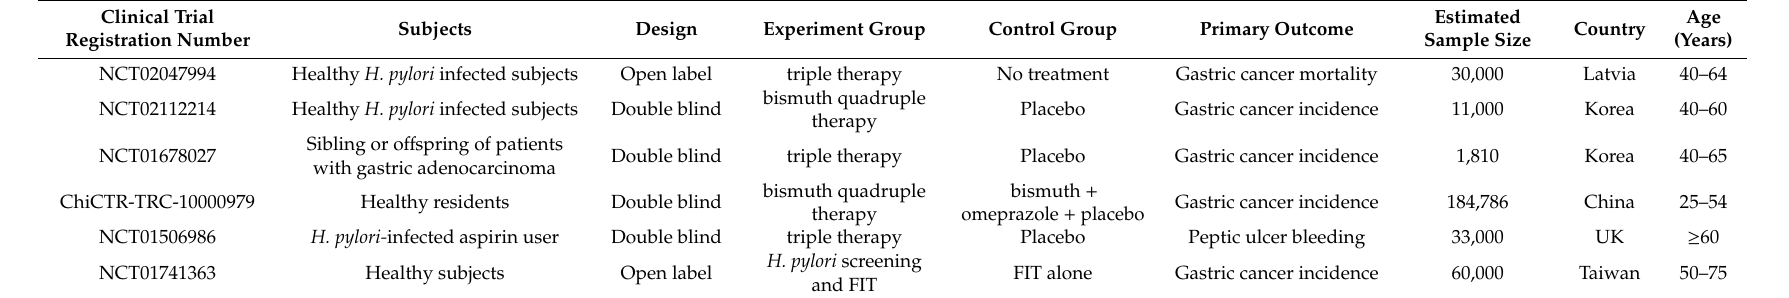
Table 3. Ongoing trials comparing the e ffi cacy of H. pylori eradication on the risk of gastric cancer.